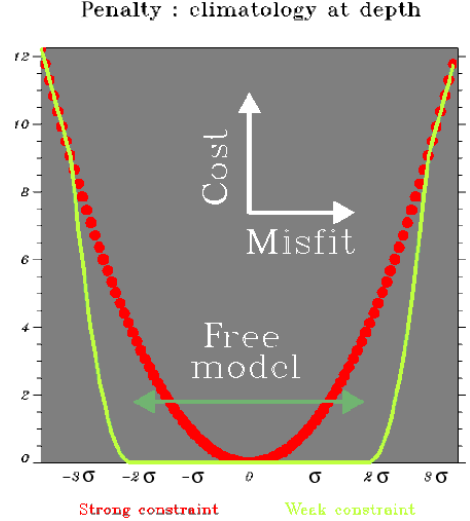
Figure 9. Non-Gaussian error for climatology (corresponding to a weak constraint of the system in green). A cost equal to zero corre- sponds to an infinite observation error, namely a system operation in a free mode (without assimilation of